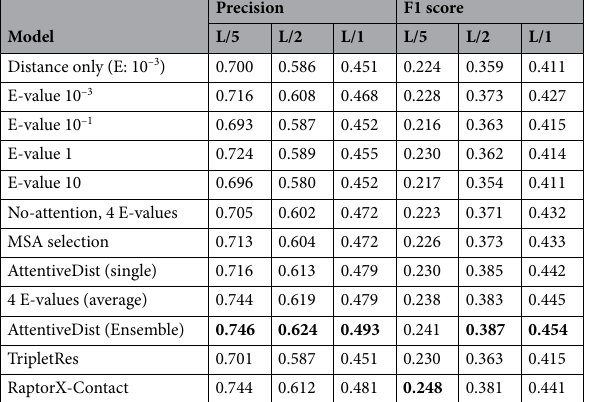
Table 1. CASP13 FM and FM/TBM 43 targets long range precision and F1 score. L/5, L/2 and L/1 shows values when top L/5, L/2 or L/1 contact predictions with the highest probabilities were considered where L is the length of the protein. Values in bold are the highest in each column.